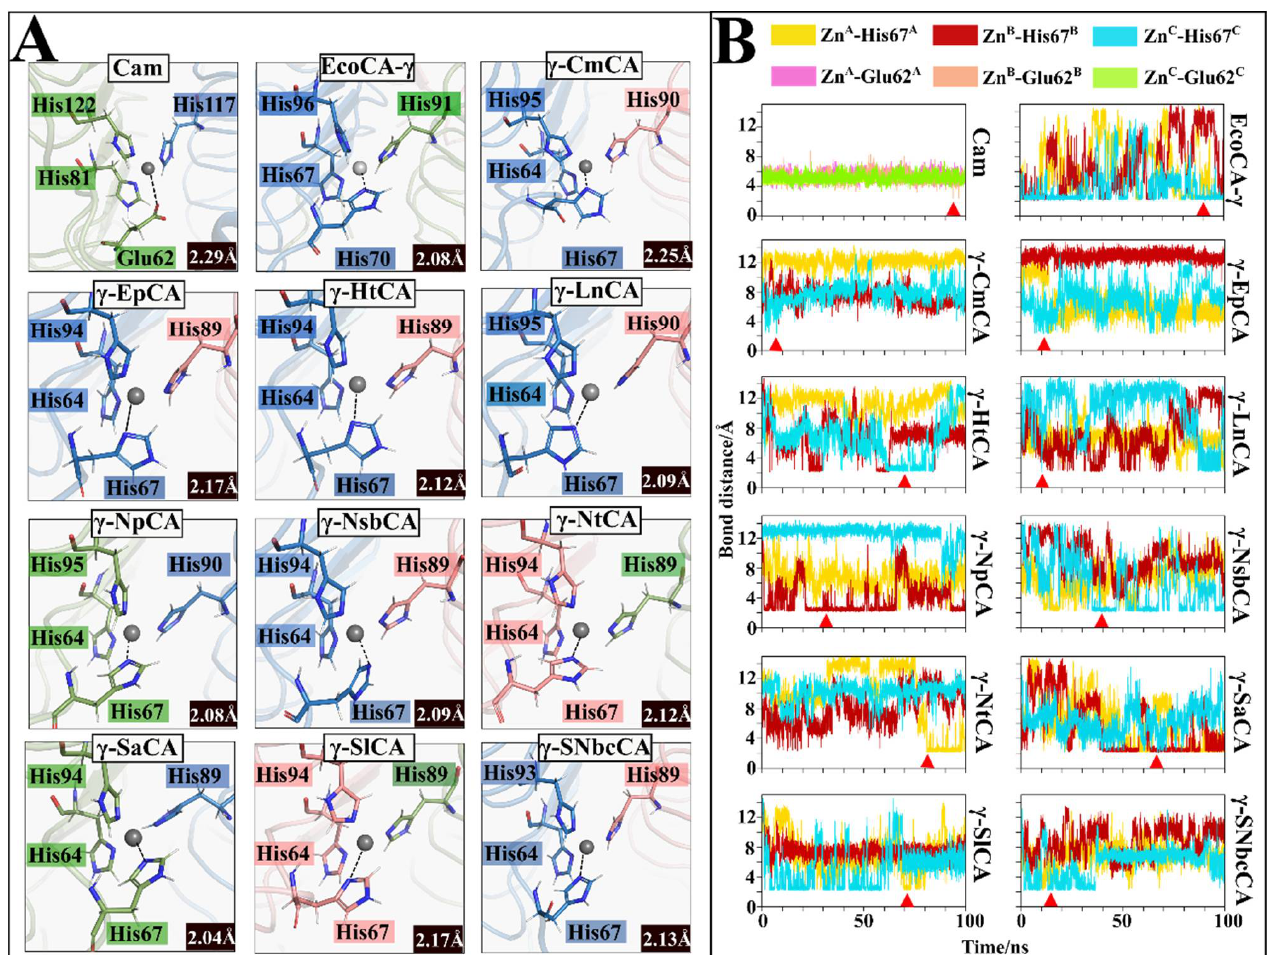
Figure 8. Zn 2+ coordination by a proton-shuttling residue. ( A ) Visualized frames of each γ-CA showing the fourth coordination position being fulfilled by His67 (Glu62 for Cam). Residues from chain A are highlighted in salmon, chain B in blue, and chain C in green. Zn 2+ is shown as a grey sphere and the Zn-His (Zn-Glu for Cam) distance is indicated in the black box in the bottom right corner of each structure. ( B ) Bond distances between Zn and the proton-shuttling residue across the 100 ns trajectories. The red triangle shows the frame from which the respective structure in ( A ) was obtained.